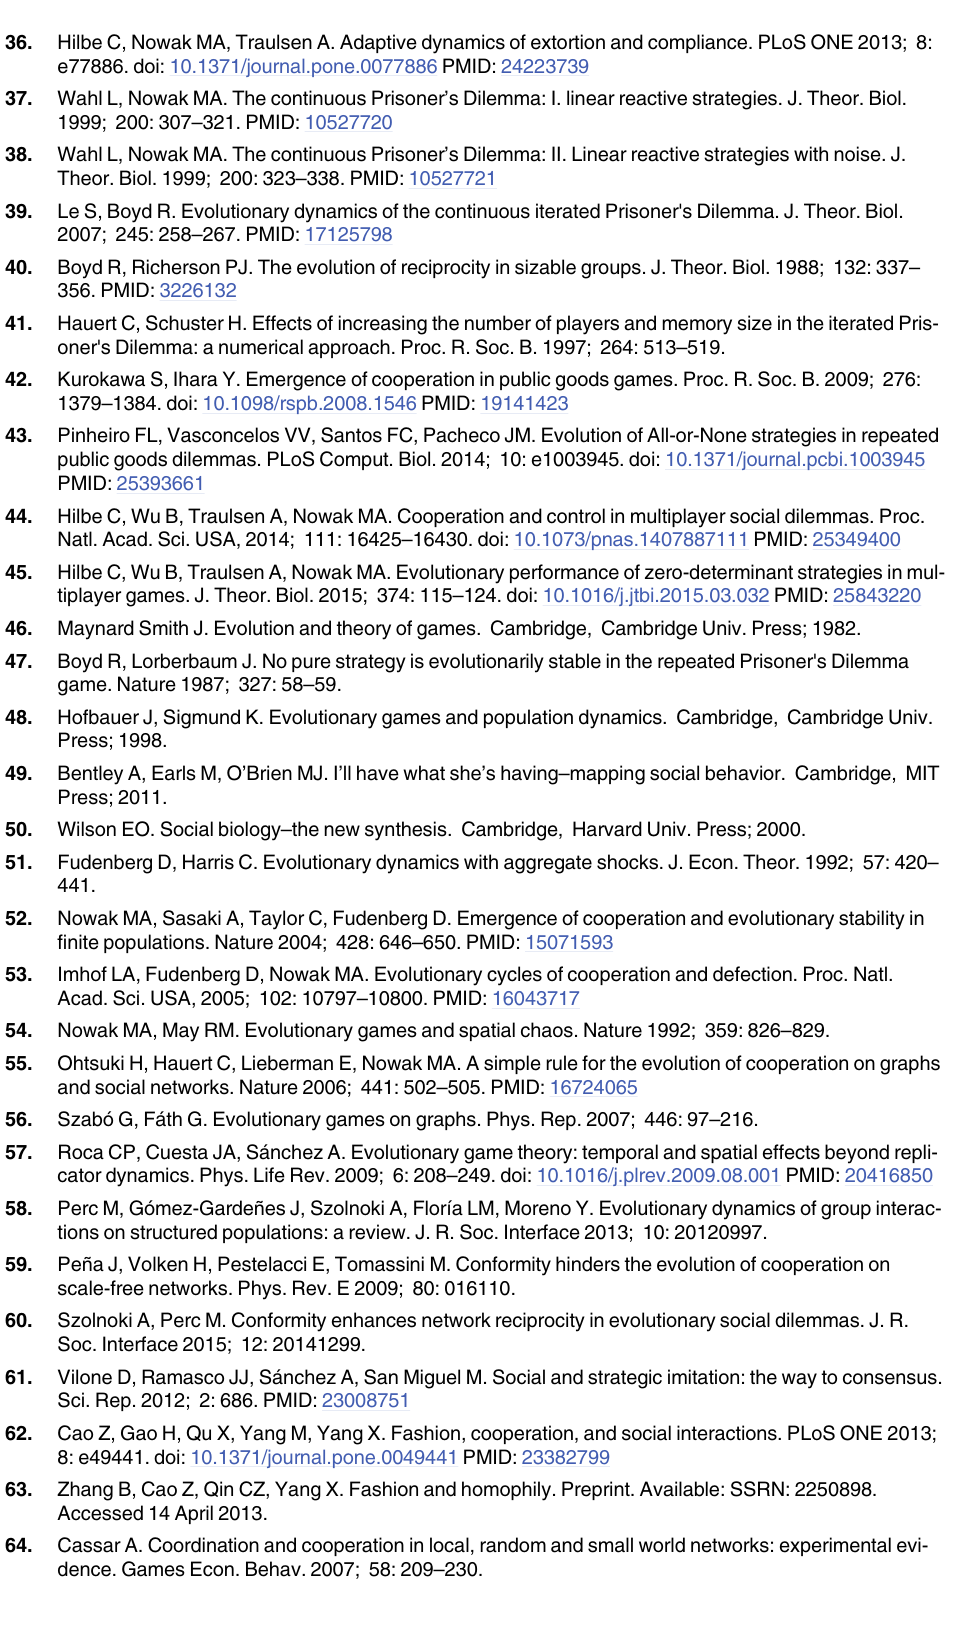
PLOS ONE | DOI:10.1371/journal.pone.0137435 September 1,